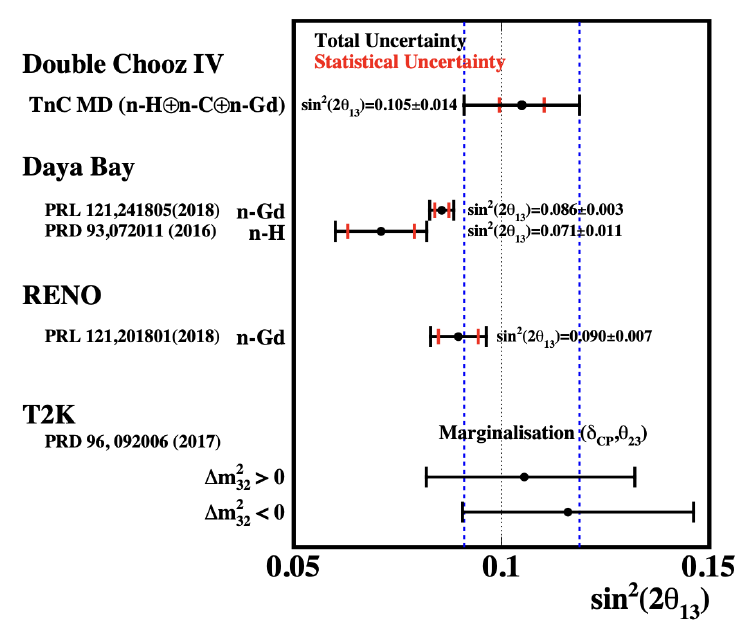
Figure 5. Latest published θ 13